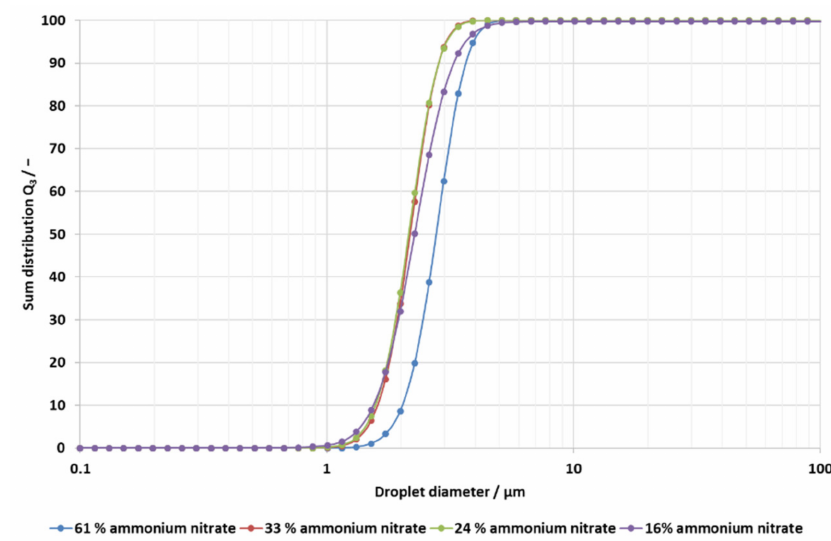
Figure 2. Droplet size distribution of the inner